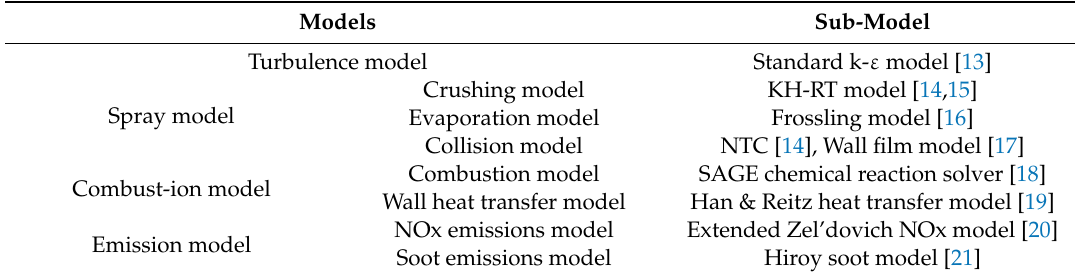
Table 2. Selection of sub-models for the CFD numerical